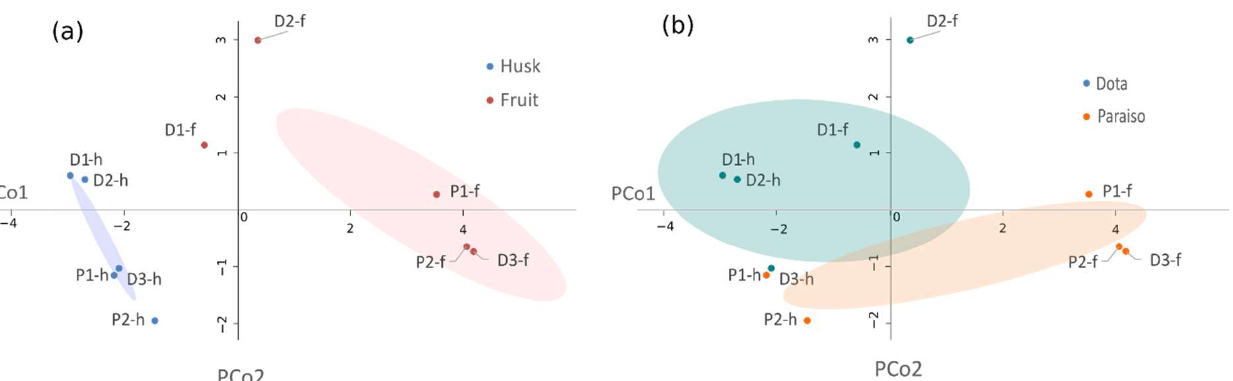
Figure 21. Principal coordinate plot performed over the Bray–Curtis distance matrix between the samples from the UPLC QTOF-ESI MS results. Ellipses show the mean distance to the centroid for each factor: ( a ) plant part and ( b )